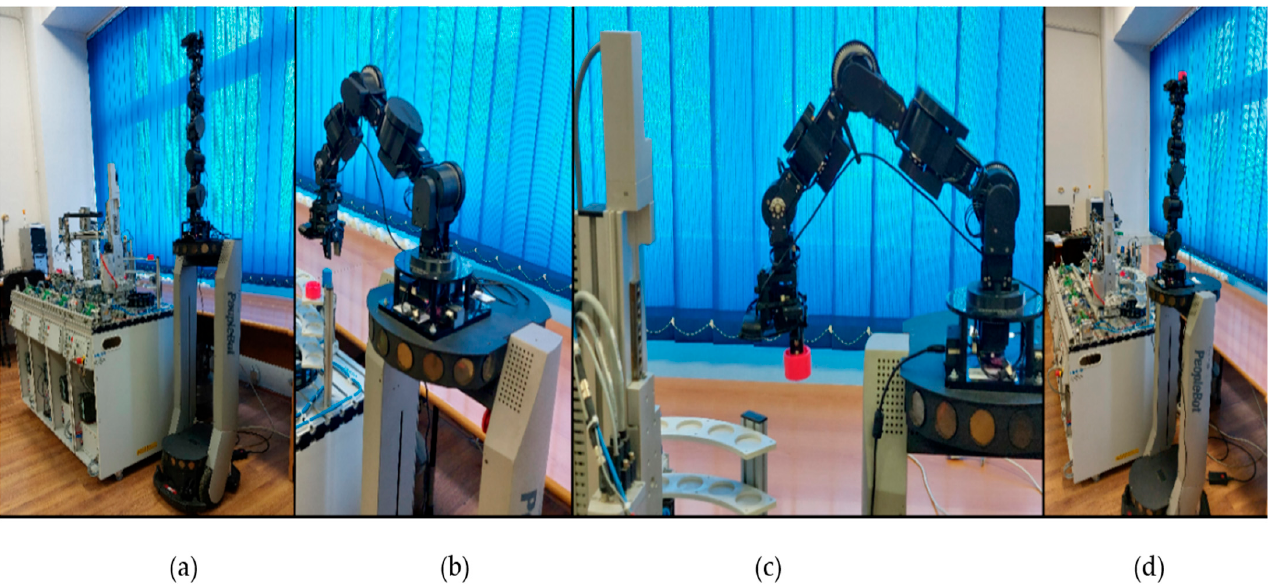
Figure 12. Real-time control of the CAS for picking up workpieces with the following order: ( a ) home position, ( b ) scanning position ( c ) picking up object ( d ) home position with the workpiece picked up in the gripper.